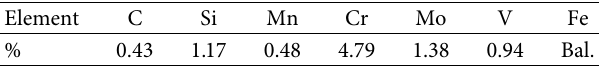
Table 1: Chemical composition of the H13 steel sample using in the experiment (weight).